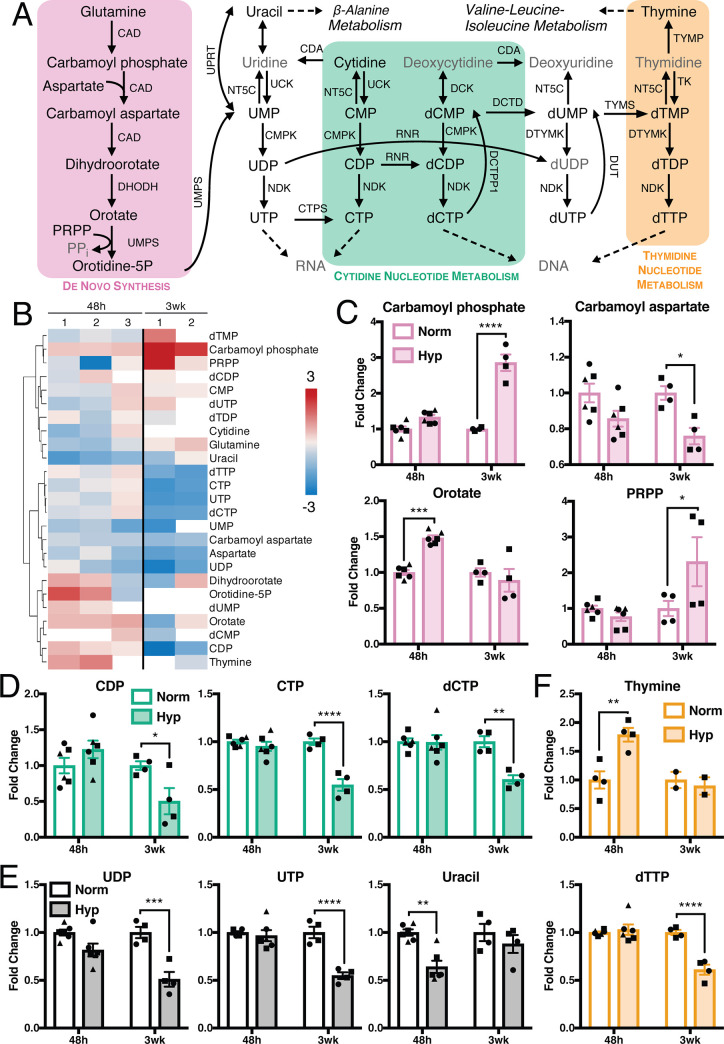
Pyrimidine nucleotides are decreased in hypoxia, while precursors accumulate.(A) Metabolites and enzymes in pyrimidine metabolism. Metabolites in gray not measured or detected. (B) Fold change metabolite abundance over normoxia control for metabolites in pathway A detected in more than one sample. White space indicates metabolite not detected. (C-E) Significantly altered metabolites from B. Significance by two-way ANOVA. All error bars represent SEM, different symbols represent biological replicates. *, p < 0.05; **, p < 0.01; ***, p < 0.001; ****, p < 0.0001. Enzyme abbreviations: CAD, carbamoyl-phosphate synthetase 2, aspartate transcarbamylase, and dihydroorotase; CDA, cytidine deaminase; CMPK, UMP-CMP kinase; CTPS, CTP synthase; DCK, deoxycytidine kinase; DCTD, deoxycytidylate deaminase; DCTPP1, dCTP pyrophosphatase 1; DHODH, dihydroorotate dehydrogenase; DTYMK, thymidylate kinase; DUT, dUTP nucleotidohydrolase; NDK, nucleoside diphosphate kinase; NT5C, 5', 3'-nucleotidase, cytosolic; RNR, ribonucleoside-diphosphate reductase; TK, thymidine kinase; TYMP, thymidine phosphorylase; TYMS, thymidylate synthase; UCK, uridine-cytidine kinase; UMPS, UMP synthase; UPRT, uracil phosphoribosyltransferase. Metabolite abbreviations: CDP, cytidine diphosphate; CMP, cytidine monophosphate; CTP, cytidine triphosphate; dCDP, deoxycytidine diphosphate; dCMP, deoxycytidine monophosphate; dCTP, deoxycytidine triphosphate; dTDP, deoxythymidine diphosphate; dTMP, deoxythymidine monophosphate; dTTP, deoxythymidine triphosphate; dUDP, deoxyuridine diphosphate; dUMP, deoxyuridine monophosphate; dUTP, deoxyuridine triphosphate; orotidine-5P, orotidine 5-phosphate; PPi, pyrophosphate; PRPP, phosphoribosyl pyrophosphate; UDP, uridine diphosphate; UMP, uridine monophosphate; UTP, uridine triphosphate.